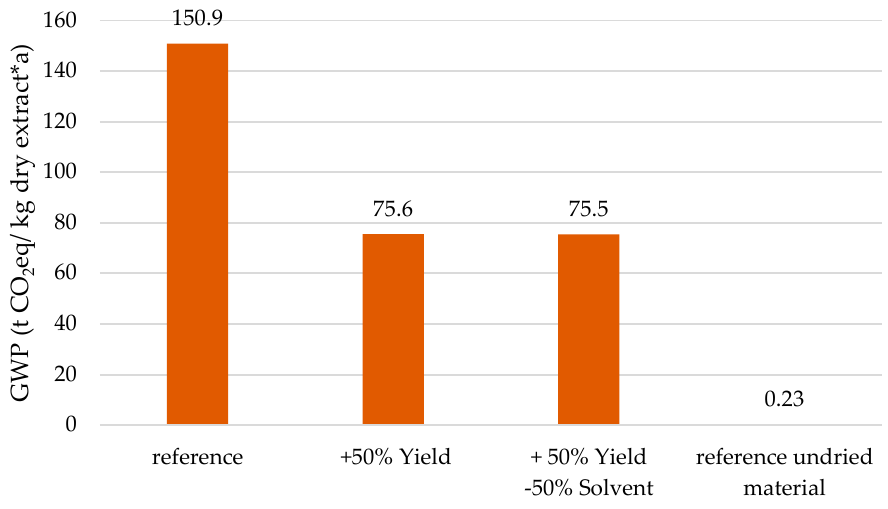
Figure 11. Impact of yield improvements on specific global warming potential (GWP) of extraction processes.